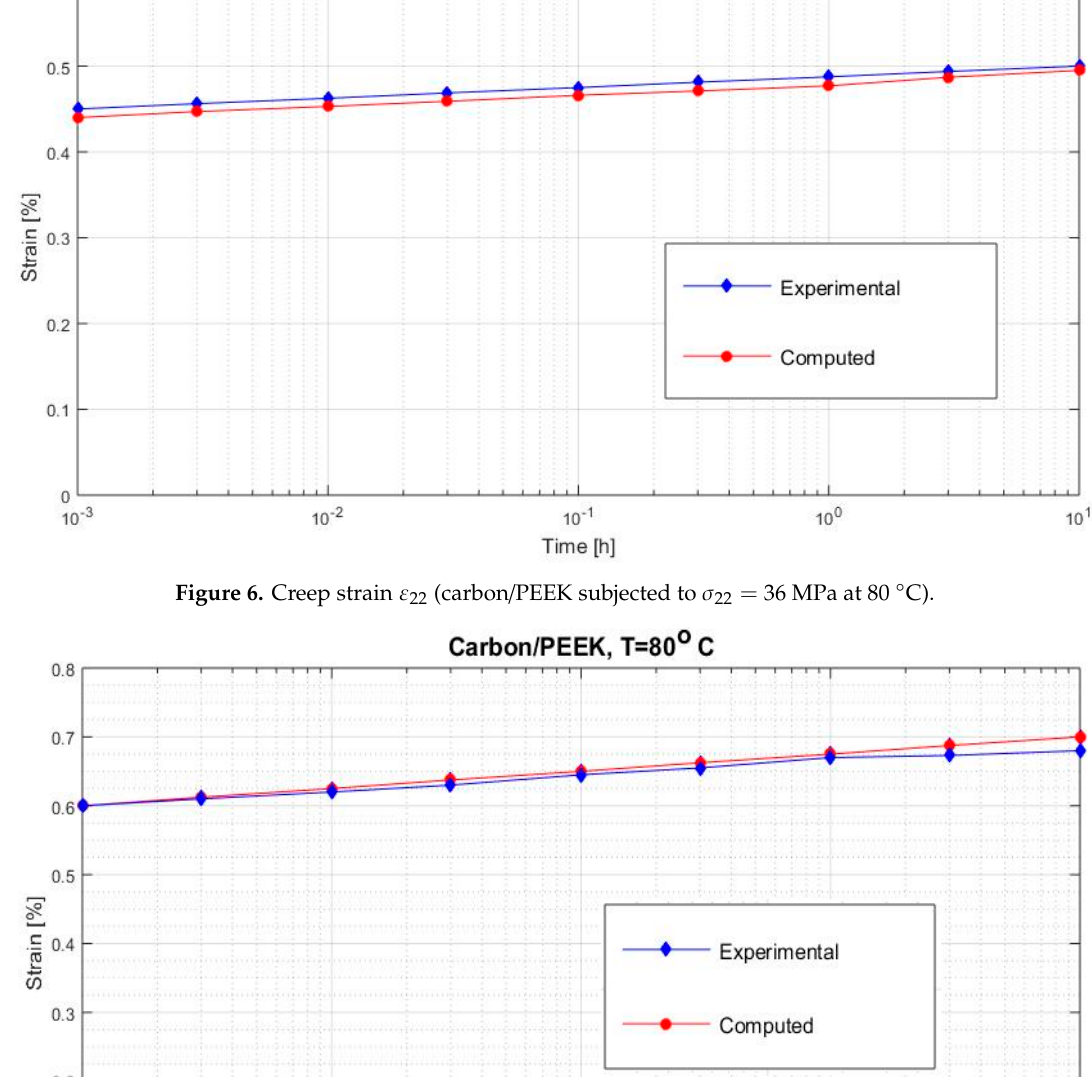
Figure 7. Creep strain ε 22 (carbon / PEEK subjected to σ 22 = 48 MPa at 80 ◦